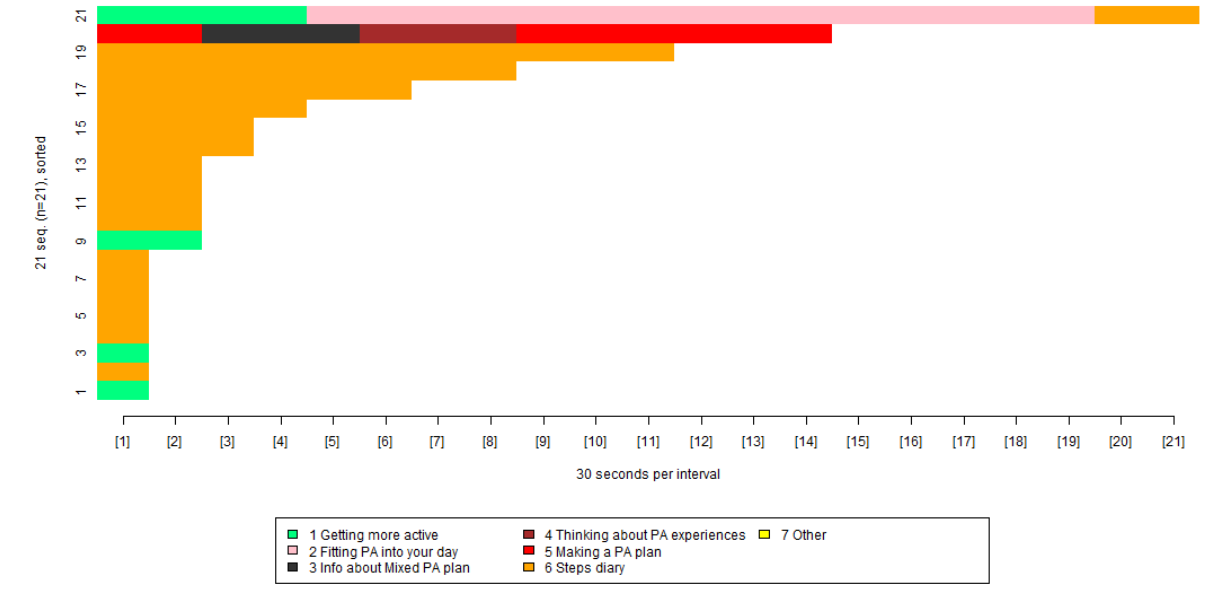
Figure 7. Visualization of participantsâ€™ repeated use of the physical activity plan